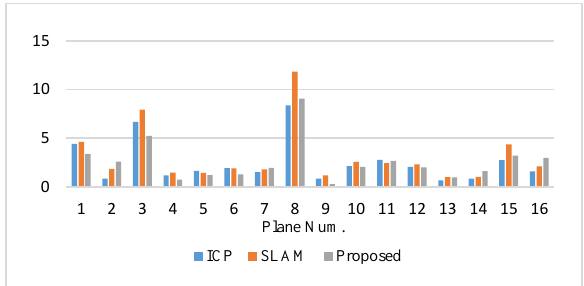
Figure 19. Plane thickness parameter for